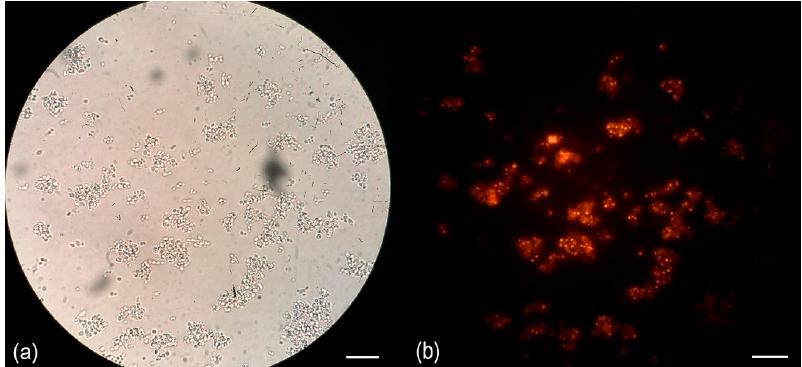
Figure 3. Photomicrographs of the Nile red-stained cells of Limtongella siamensis DMKU-JMGT1-45 diluted two folds from a cell density og 1.7 × 10 9 cell/mL when cultivated in a nitrogen-limited medium II broth at 150 rpm and 28 °C for 72 h. Bar, 20 µm: ( a ) bright-field image; ( b ) fluorescence image. Table 2. The fatty acid contents in Limtongella siamensis DMKU-JMGT1-45 and other oleaginous yeasts. Yeast